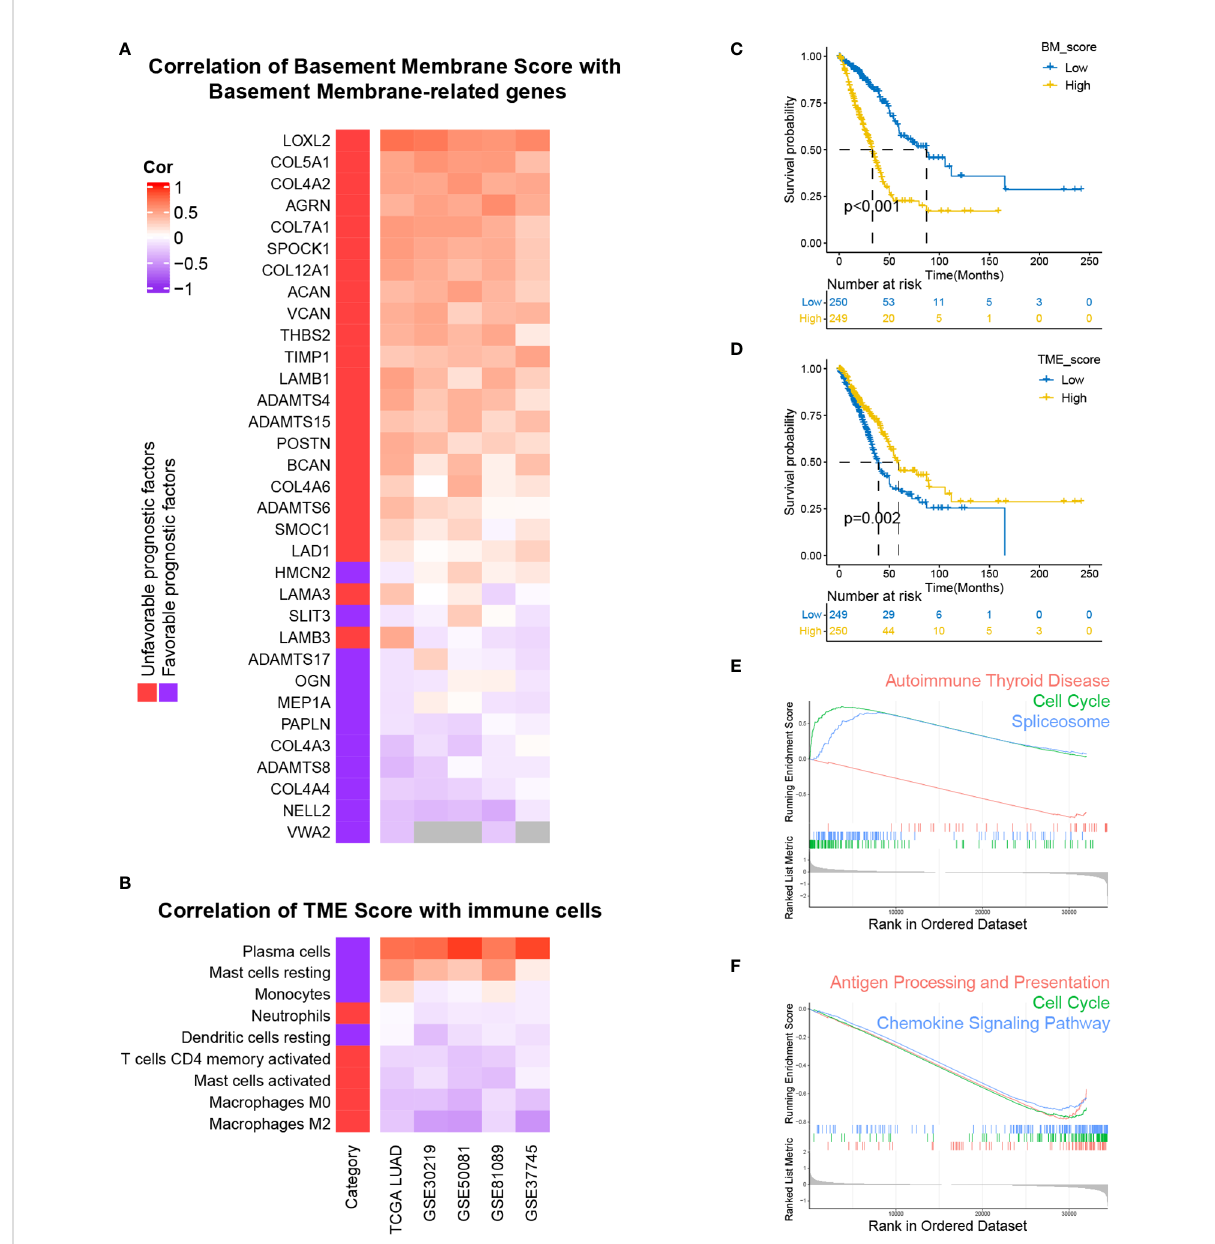
FIGURE 2 Development and performance of BM and TME scores in LUAD, respectively. (A, B) The correlation of BM score and TME score with the expression levels of prognostically BM genes and the abundance of prognostically immune cells. (C, D) Kaplan – Meier survival curves of high and low BM, TME scores subgroups. (E, F) Top three KEGG enrichment pathways based on GSEA analysis of differentially expressed genes (DEGs) between high and low BM, TME scores